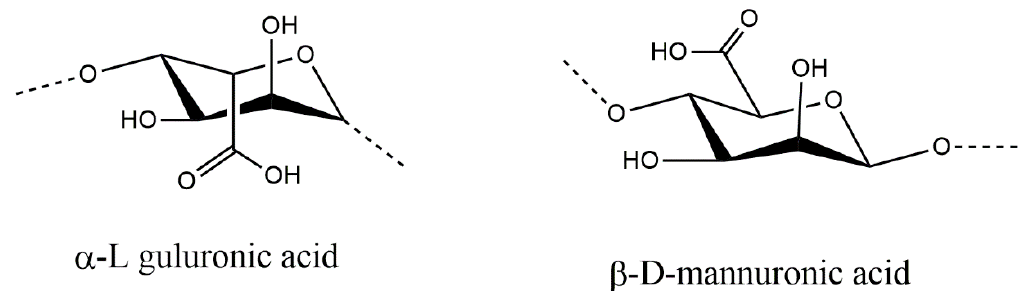
Figure 2. 1 H NMR spectrum of Na-alginate (SA) from Sargassum muticum.